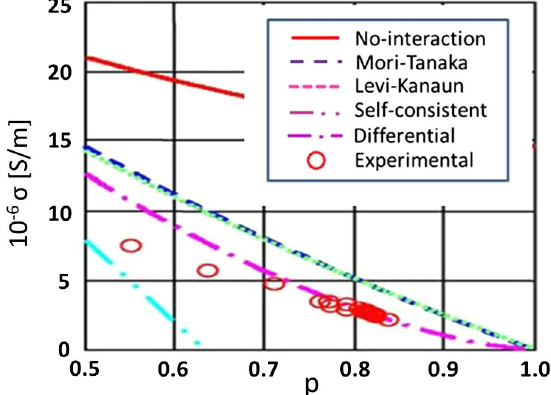
FIG. 4. Static conductivity vs porosity for aluminum based foams from different EMT models. Measured values are also shown (adapted from